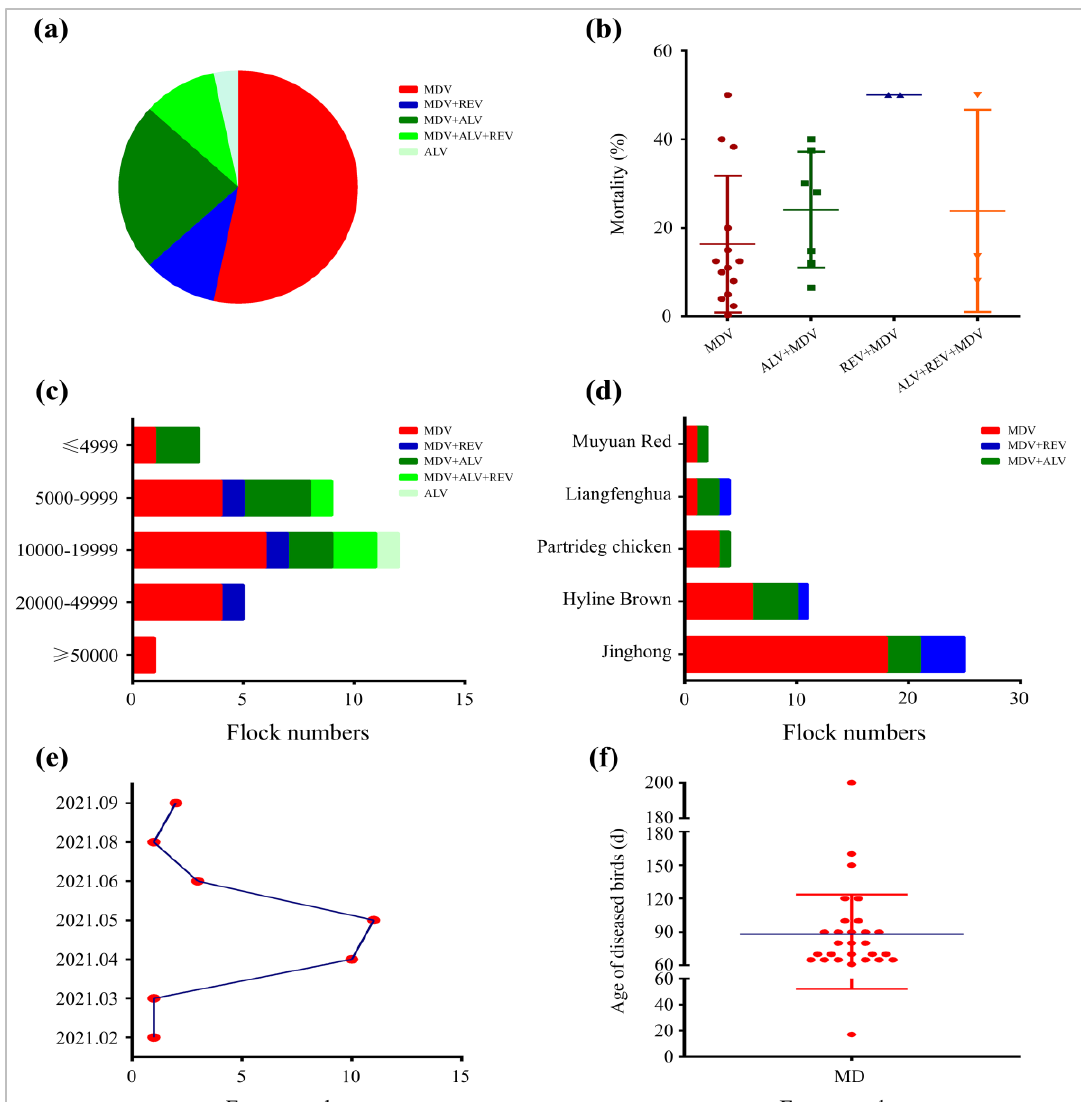
Figure 3. Epidemiological data analysis of MDV, ALV, and REV infections in chicken flocks selected from 30 poultry farms. ( a ) Distribution schematic of mono or co-infections of MDV, ALV, and/or REV in chicken flocks. ( b ) Mortality of chickens infected with MDV or co-infected with different combination of viruses. ( c ) Distribution of three pathogens in different sizes of chicken flocks. ( d ) Distribution of three pathogens in different chicken breeds. ( e ) Numbers of case reports at different time points. ( f ) Statistic of the onset age of disease for MD cases.